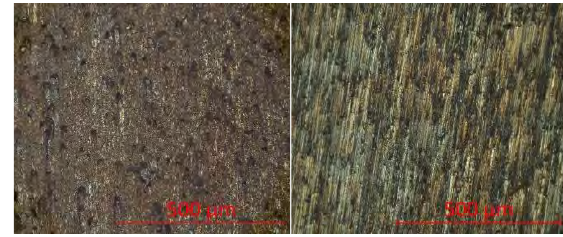
Fig . 6 . Grinding tools with grit size D30 on the left and D15 on the right